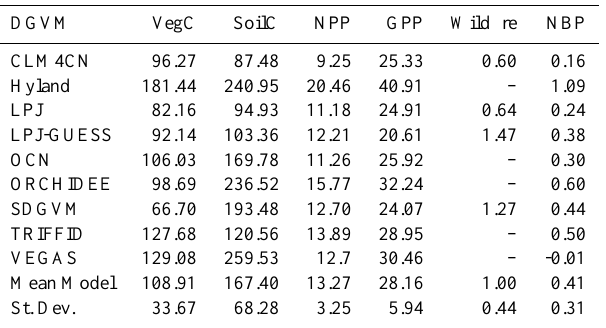
Fig. 4. Average net primary productivity (NPP) for each DGVM and model mean over the period 1990–2009, units, g C m − 2 yr − 1 (from Sitch et al., 2014).